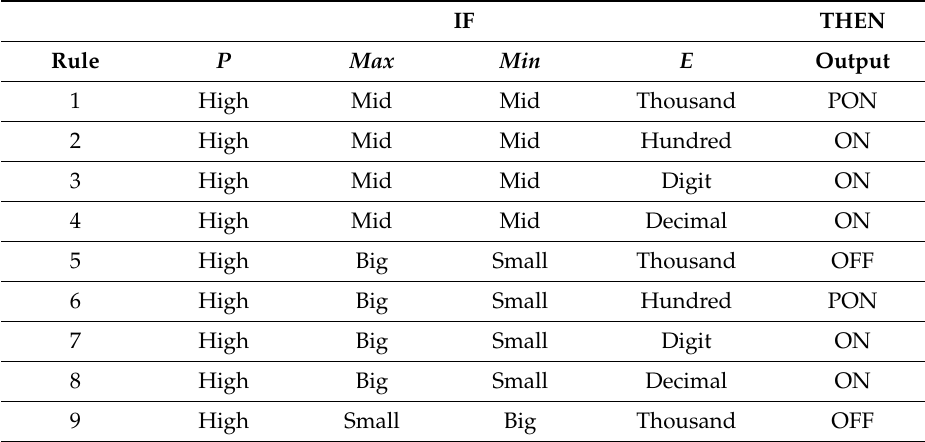
Table 3. Fuzzy rules for fault identification and trigger of protective